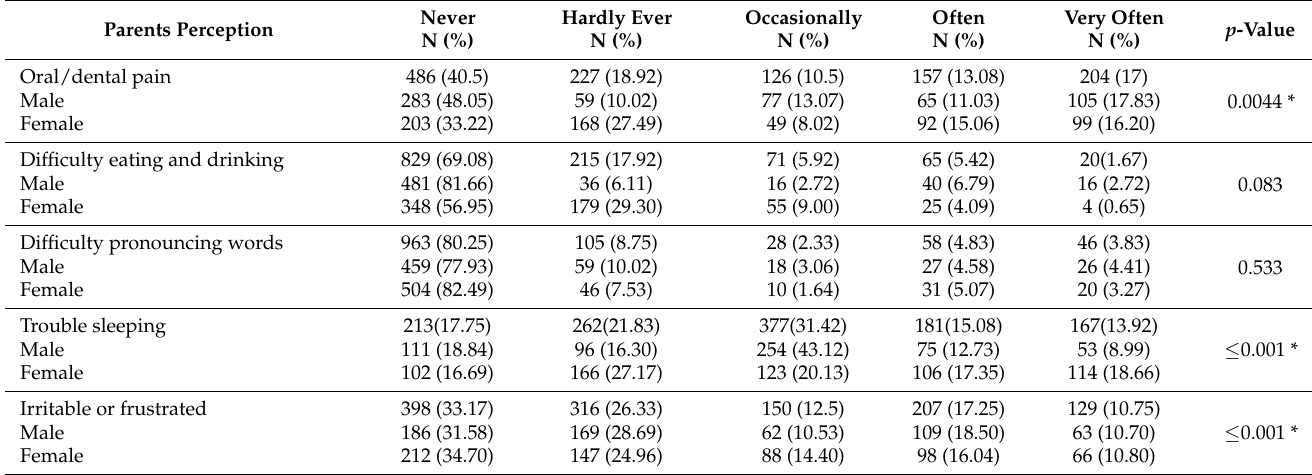
Table 4. ECOHIS self-administered questionnaire responses of parents’ perception about oral health of children (N =